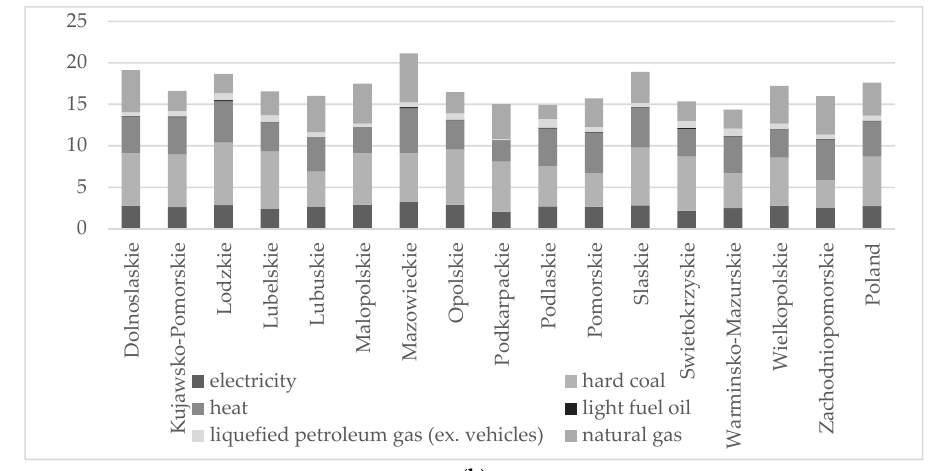
Figure 4. Energy use in households per capita by fuels in 2006 ( a ) and 2017 ( b ) [GJ/person]. Source: Own calculation.